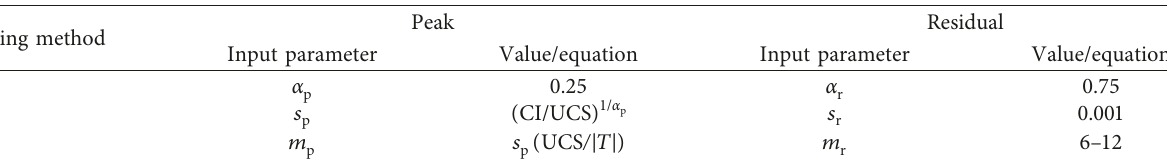
Table 1: The equations for determining the DISL model input parameters after [16]. The parameters α , s , and m shown here are defined as material constants based on the crack initiation (CI) stress, the unconfined compressive strength (UCS), and the tensile strength ( T ) of the rock. The subscripts s and r stand for the peak and residual values, respectively (adopted from [3]).